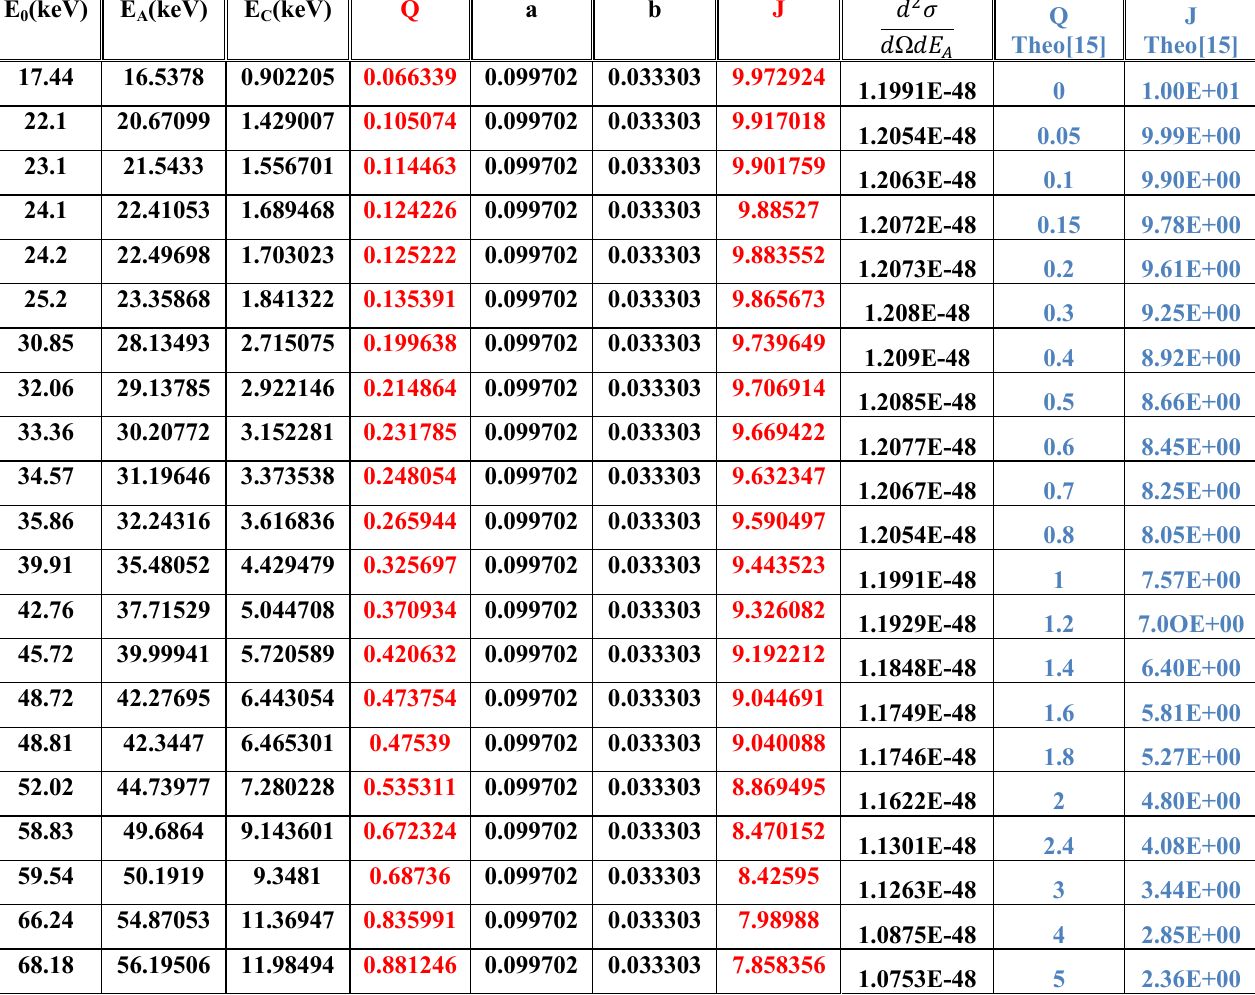
Table 4: Compton profile and double-differential scattering cross section of doppler broadening for ( 79